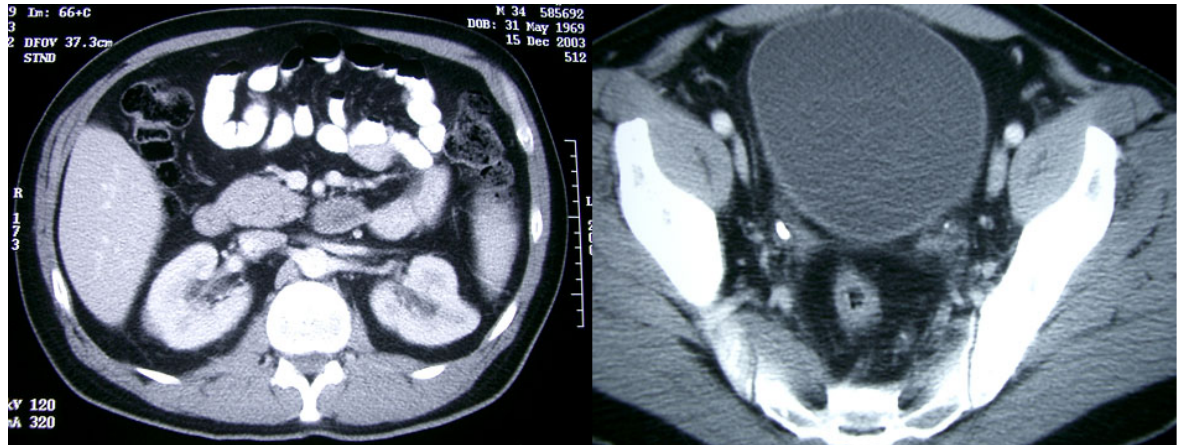
FIGURE 3. Axial computed tomography images demonstrating resolution of the previous extensive urinary tract lymphoma and its associated obstruction (left) with the bladder wall now normal